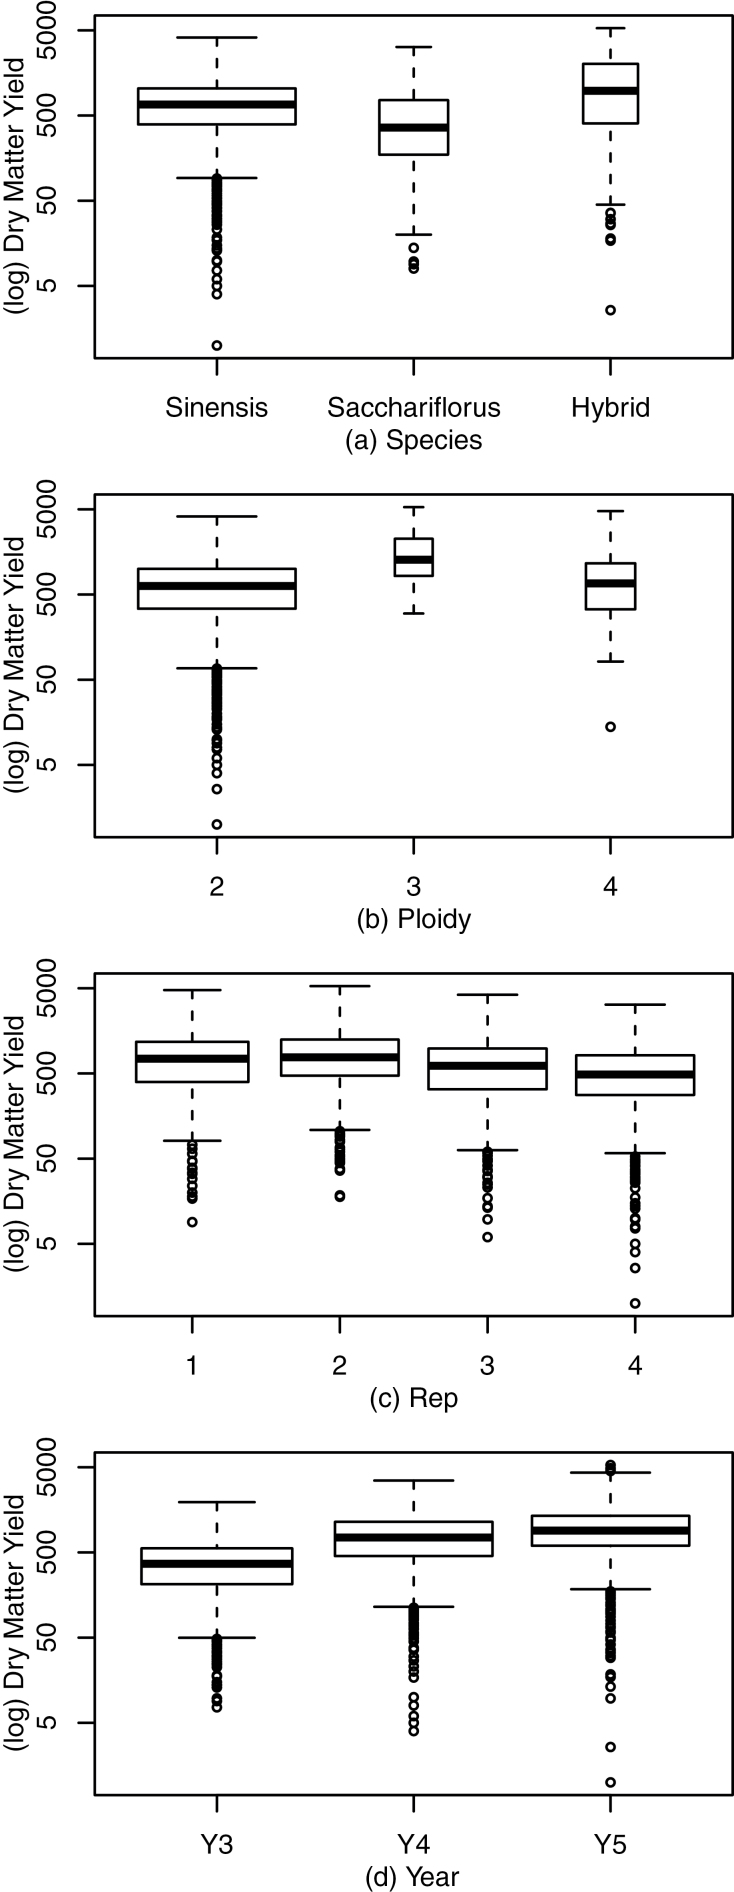
Comparison of log(DMY) across experimental traits of species (a), ploidy (b), and intrinsic traits of replicate block (c) and year (d). Widths of boxes indicate the number of plants within each group (see Table 1).